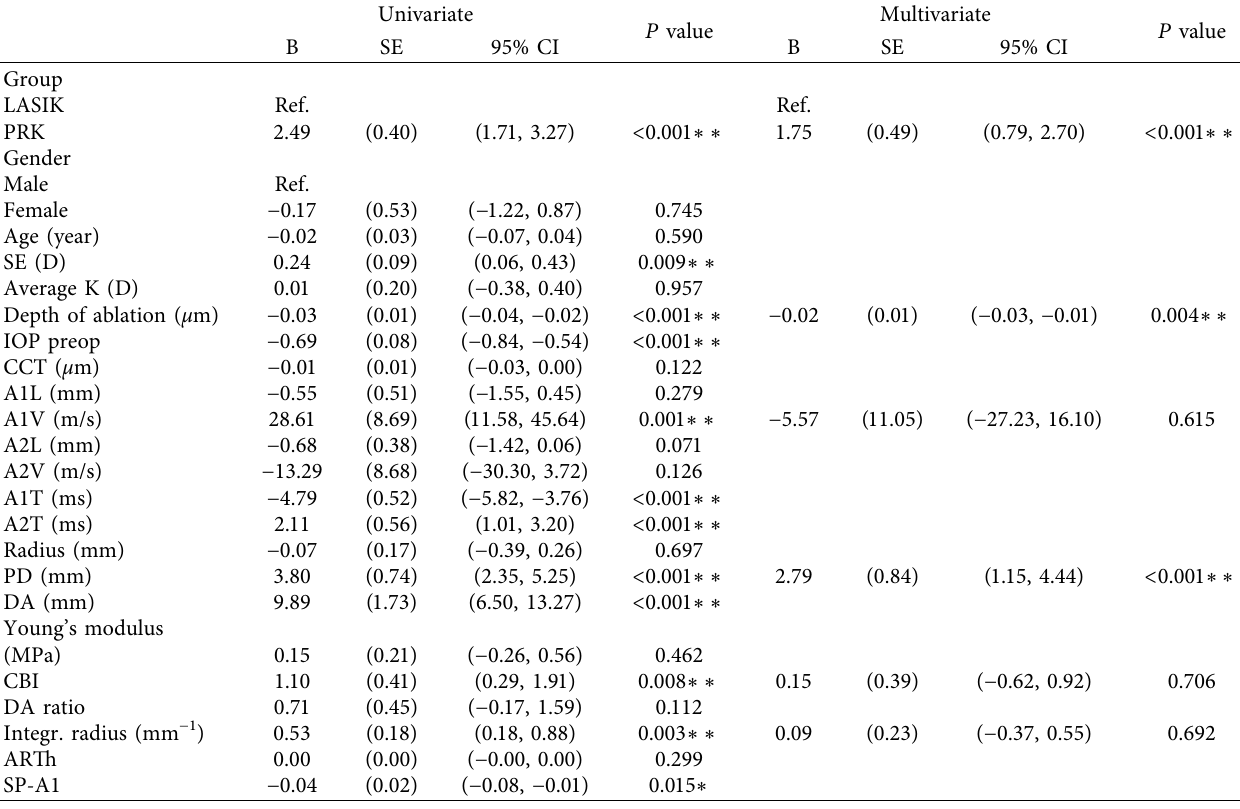
Table 3: Potential factors affecting the changes in IOP after FS-LASIK and TPRK were analyzed with marginal linear regression models using the GEE.